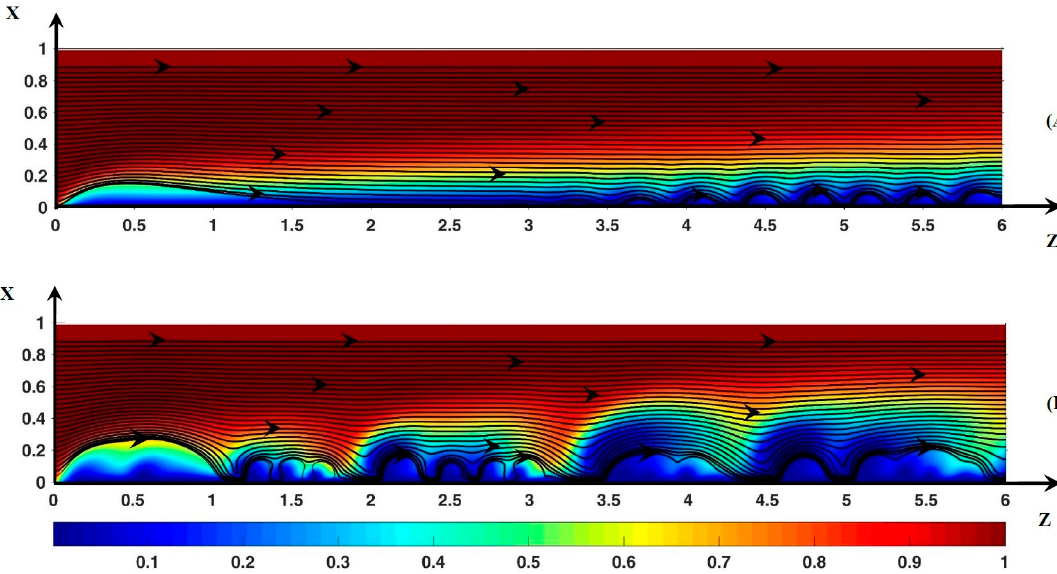
Figure 4. Color plot of the cationic concentration. ( A ): ∆Φ = 22, ( B ): ∆Φ = 30. The black lines represent the static streamlines.